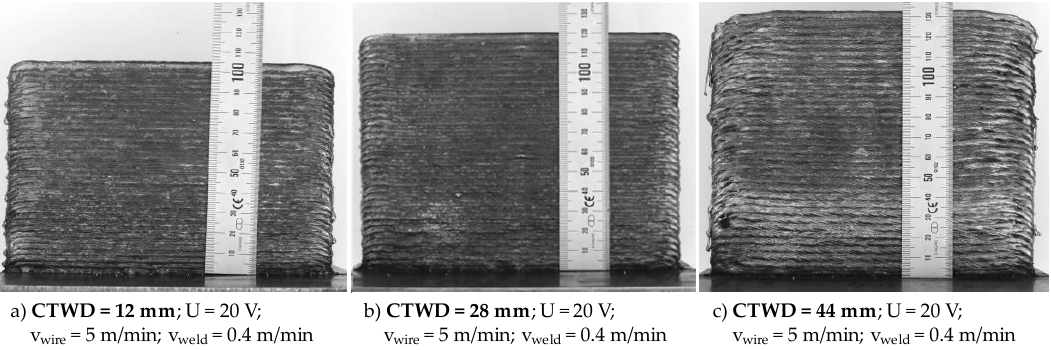
Figure 11. WAAM of wall structures with 70 layers and differing CTWD.